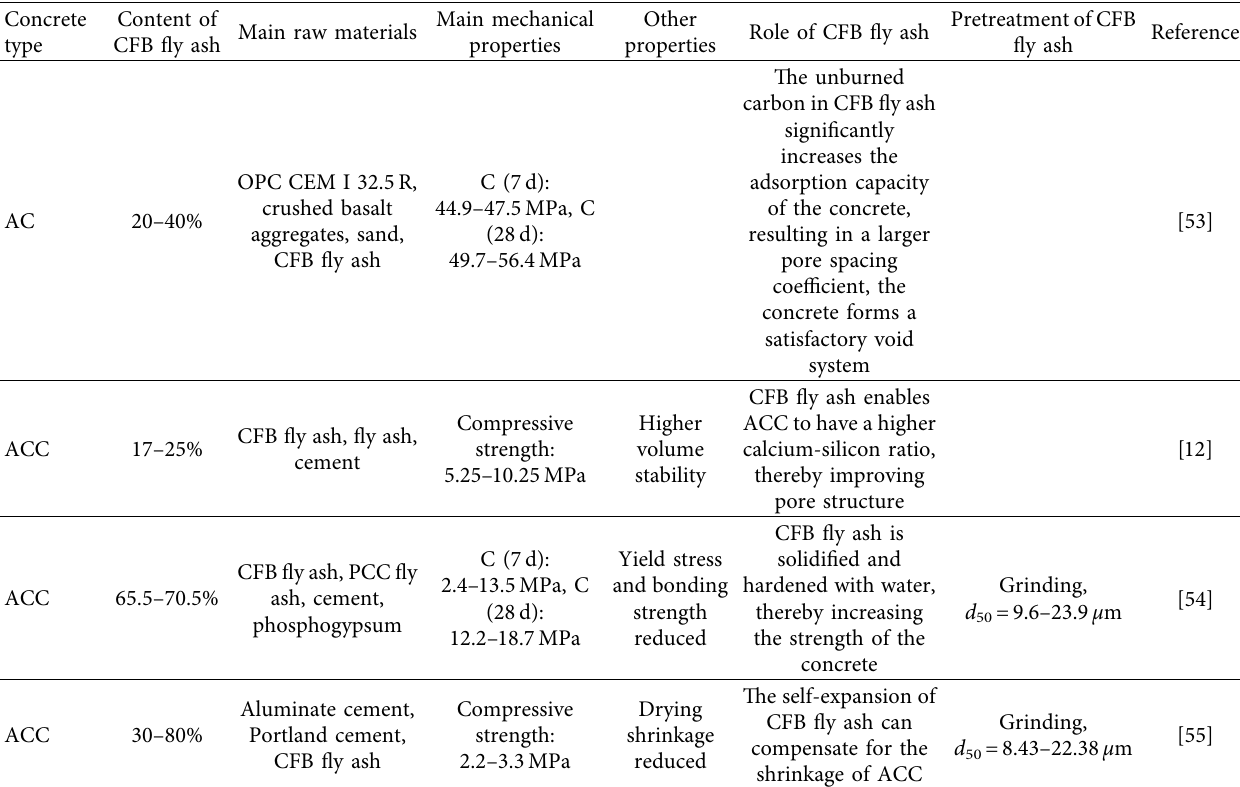
Table 5: Application of CFB fy ash in light-weight concrete.